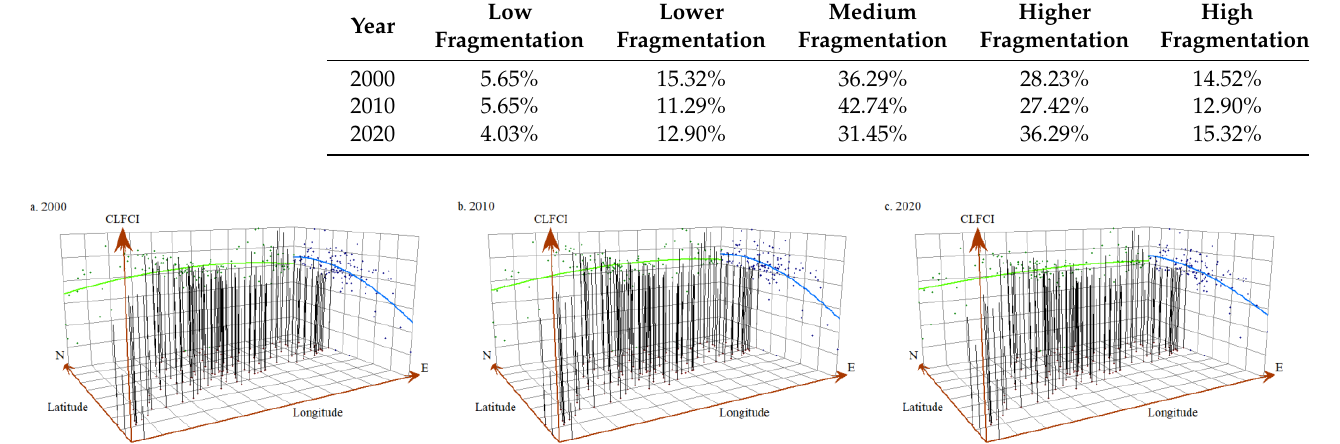
Figure 5. Spatial distribution trend of CLF in Guangdong Province on the county scale in 2000 ( a ), 2010 ( b ), and 2020 ( c ). The spatial distribution trend of CLF in Guangdong Province on the county scale in 2000, 2010, and 2020 are displayed in ( a ), ( b ), and ( c ), respectively.